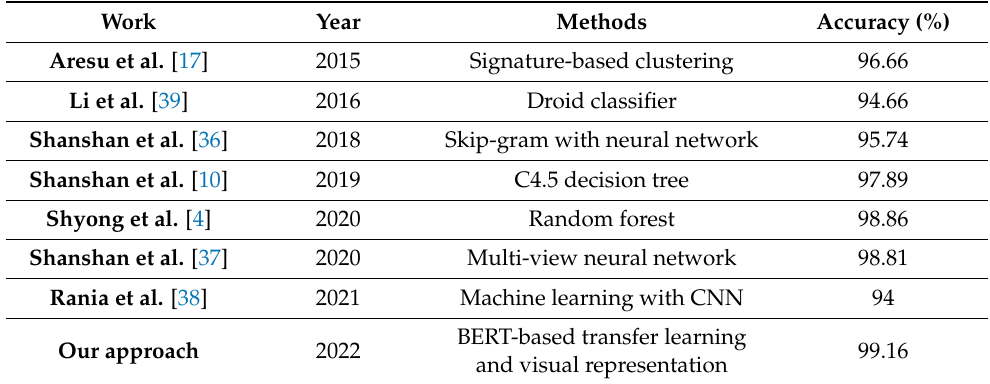
Table 7. Comparisons with published